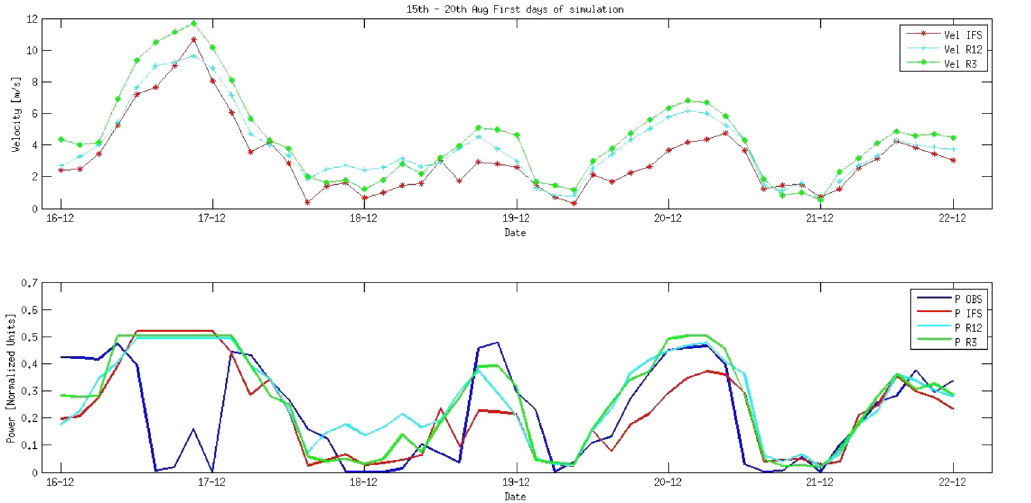
Figure 5. Upper panel: the wind velocity forecasts for the period 15–20 December 2011 (R3 is the green curve, R12 is the cyan curve and IFS is the red curve). Lower panel: comparison between the observed (blue curve), R3 (green curve), R12 (cyan curve) and IFS (red curve) wind powers for the same period of the upper panel. Note that the power forecast reached the plateau of Fig. 2, which differs for each model, for part of 16 and 17 December 2011 (wind speeds larger than 6.5ms − 1